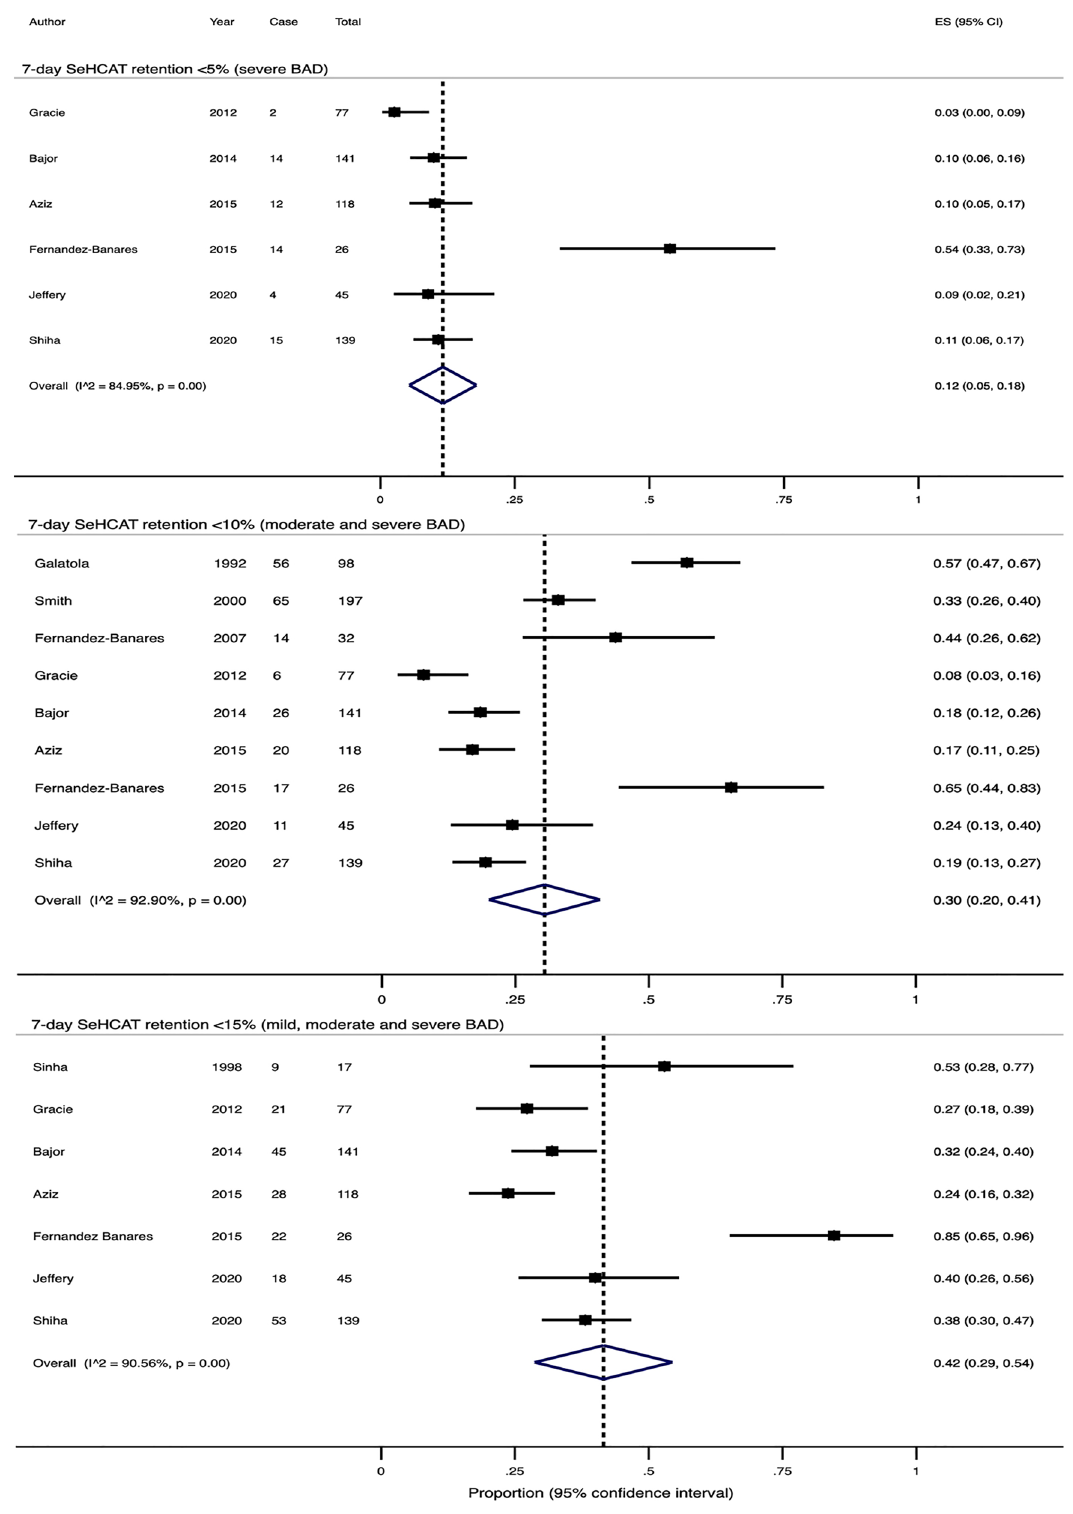
Figure 1. Forest plots showing the estimated pooled prevalence of BAD diagnosed with SeHCAT in patients fulfilling IBS criteria, if the Rome IV criteria were used by Shiha et